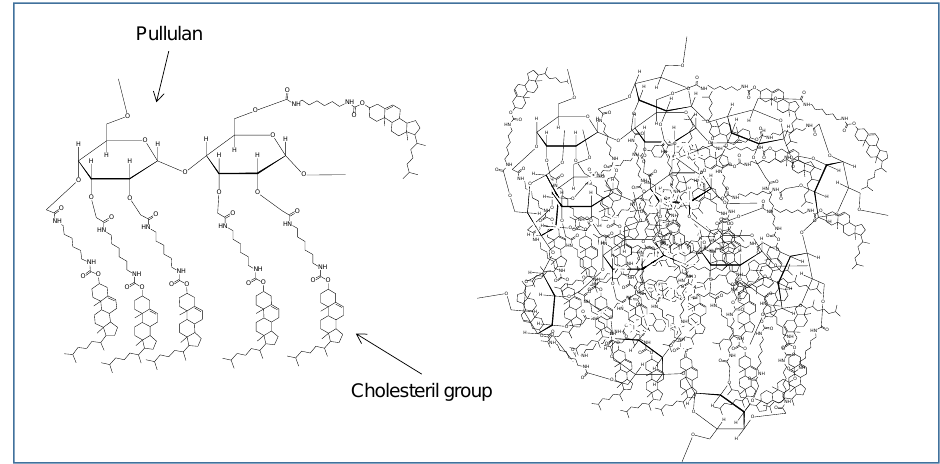
Figure 3. Schematic representation of cholesteryl pullulan polysaccharide (CHP)-nanogel (right). Chemical structure of (CHP) (left).